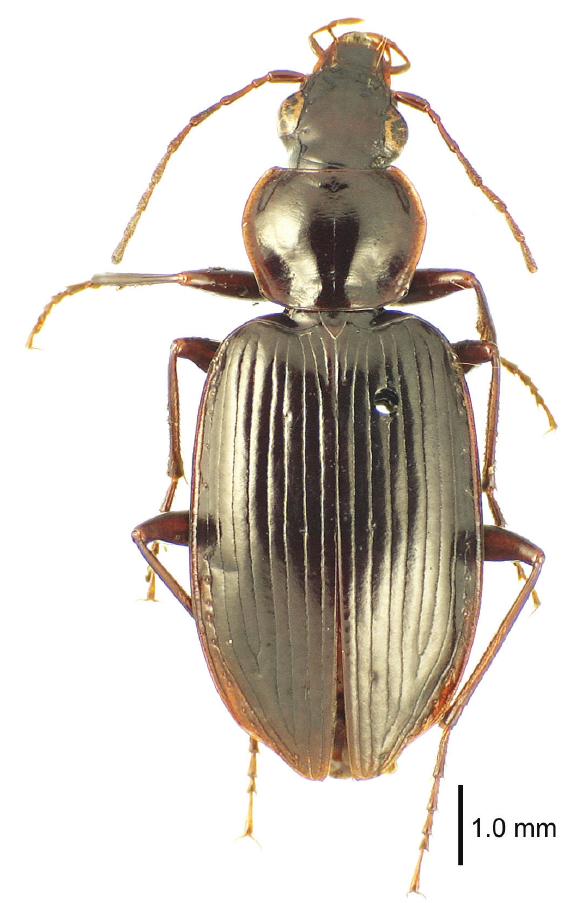
Figure 5. Notagonum kanak female (MNHN), label data: Ncalédonie / ile d. Pins / f. Faustien // MUSEUM PARIS / Ex. Coll. M. MAINDRON / Coll. G. BABAULT 1930 // Colpodes / kanak / Fauvel dedit 1906 (card mounted, abdomen removed, female genitalia and reproductive tract in vial on